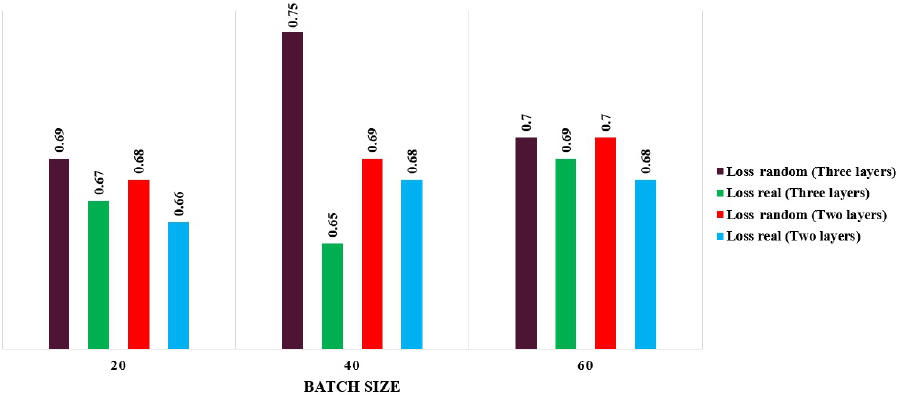
Figure 8. The discriminator’s loss per various batch sizes and hidden layers.